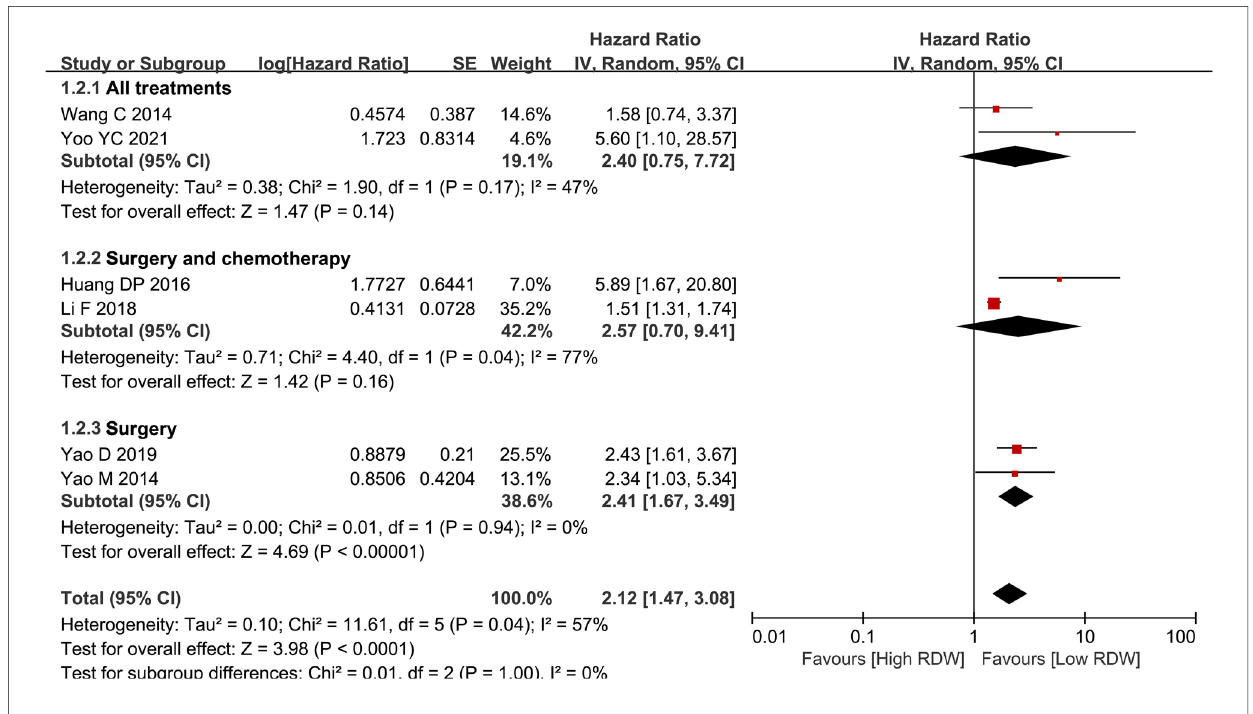
FIGURE 4 Subgroup analysis for OS based on treatment. Abbreviation: RDW, red blood cell distribution